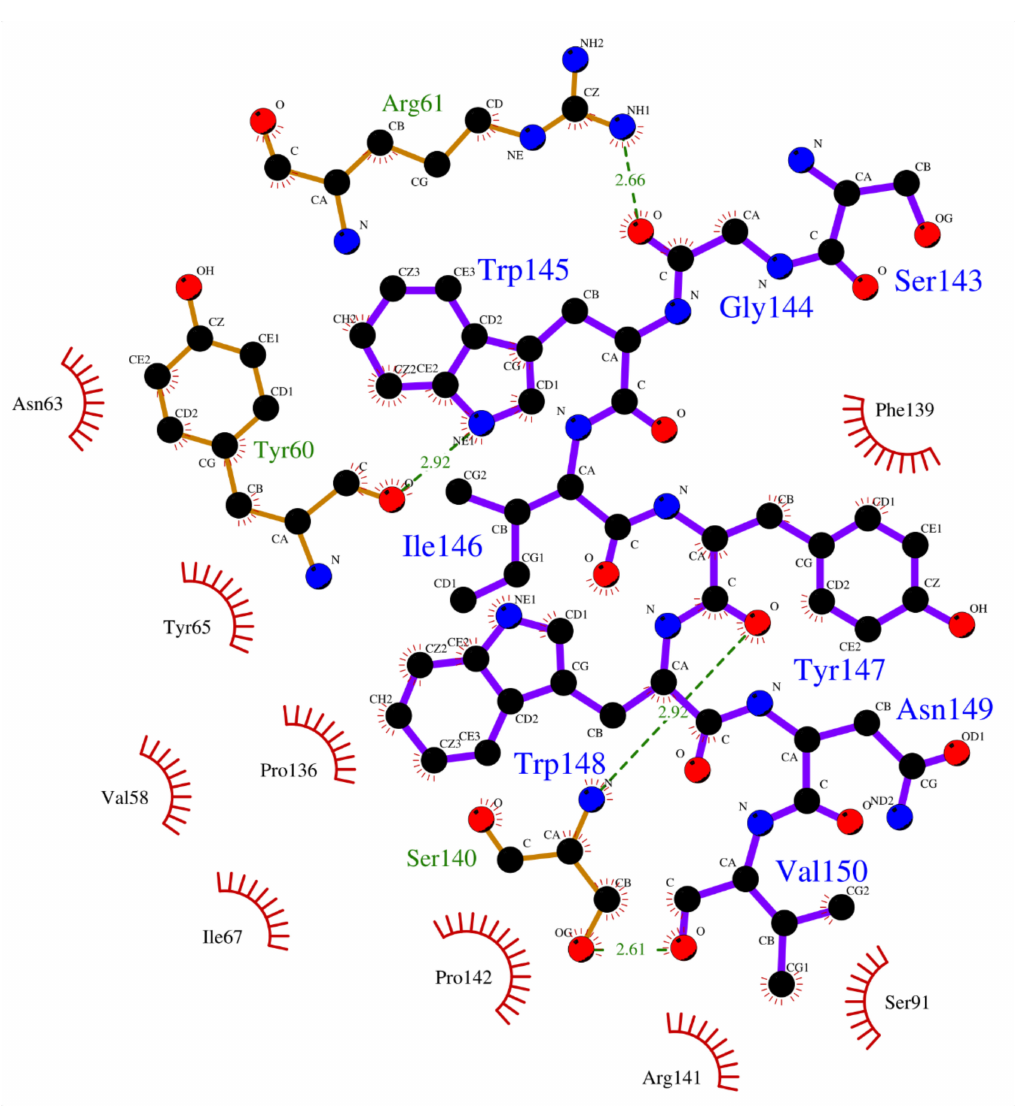
Figure 5. Overview of binding modes of the UEV domain proteins with